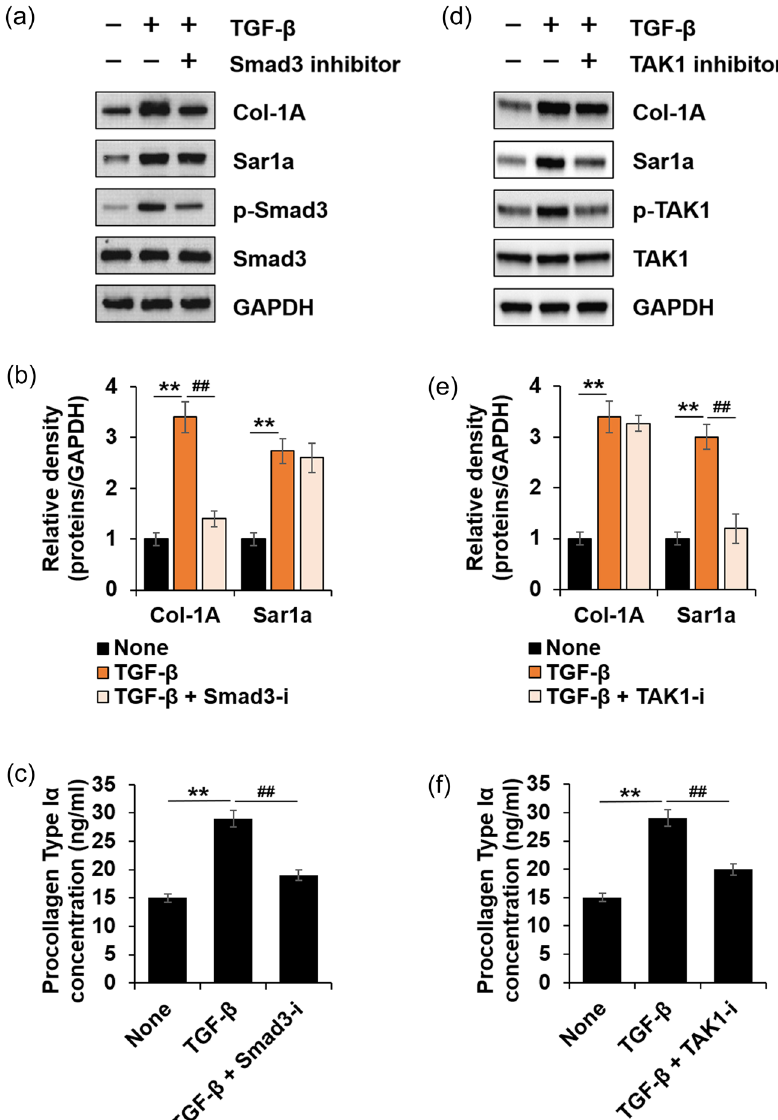
Figure 3: TAK1 is involved in TGF - β 1 - induced Sar1a expression. HTSF cultured in 6 - well plates were serum - starved for 16 h, and they were then treated with or without 10 ng/mL TGF - β 1, TGF - β 1 + 10 μ M SIS3, or TGF - β 1 + 10 μ M TAK1 inhibitor ( EDHS - 206 ) for 24 h. The cell